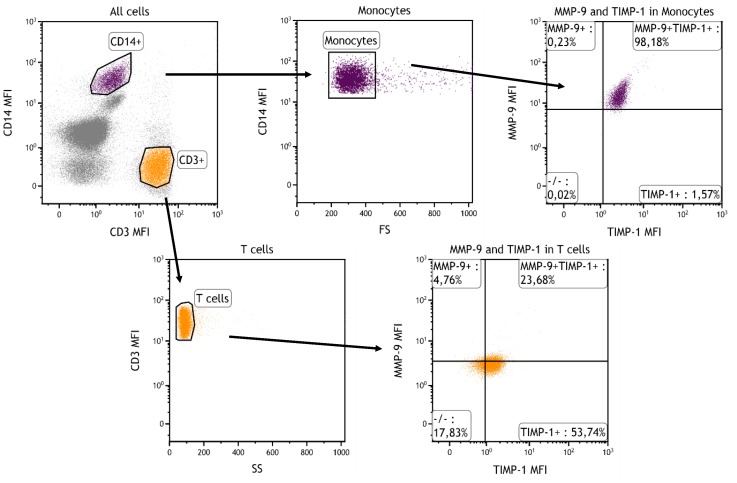
Gating strategy and representative flow cytometry plot of MMP-9-positive and TIMP-1-positive monocytes and T cells.